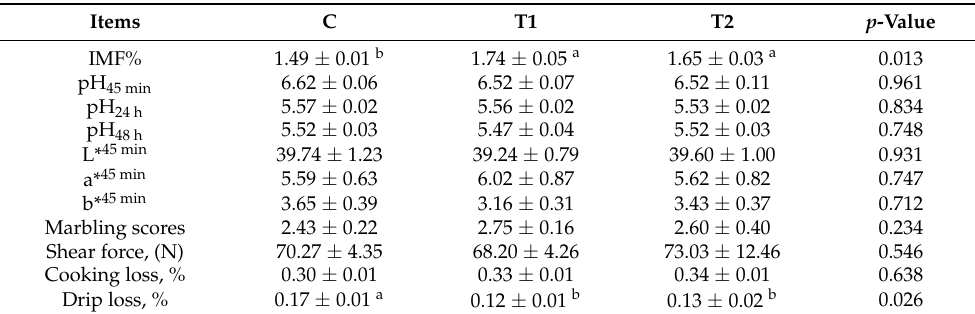
Table 4. Longest back muscle quality in growing